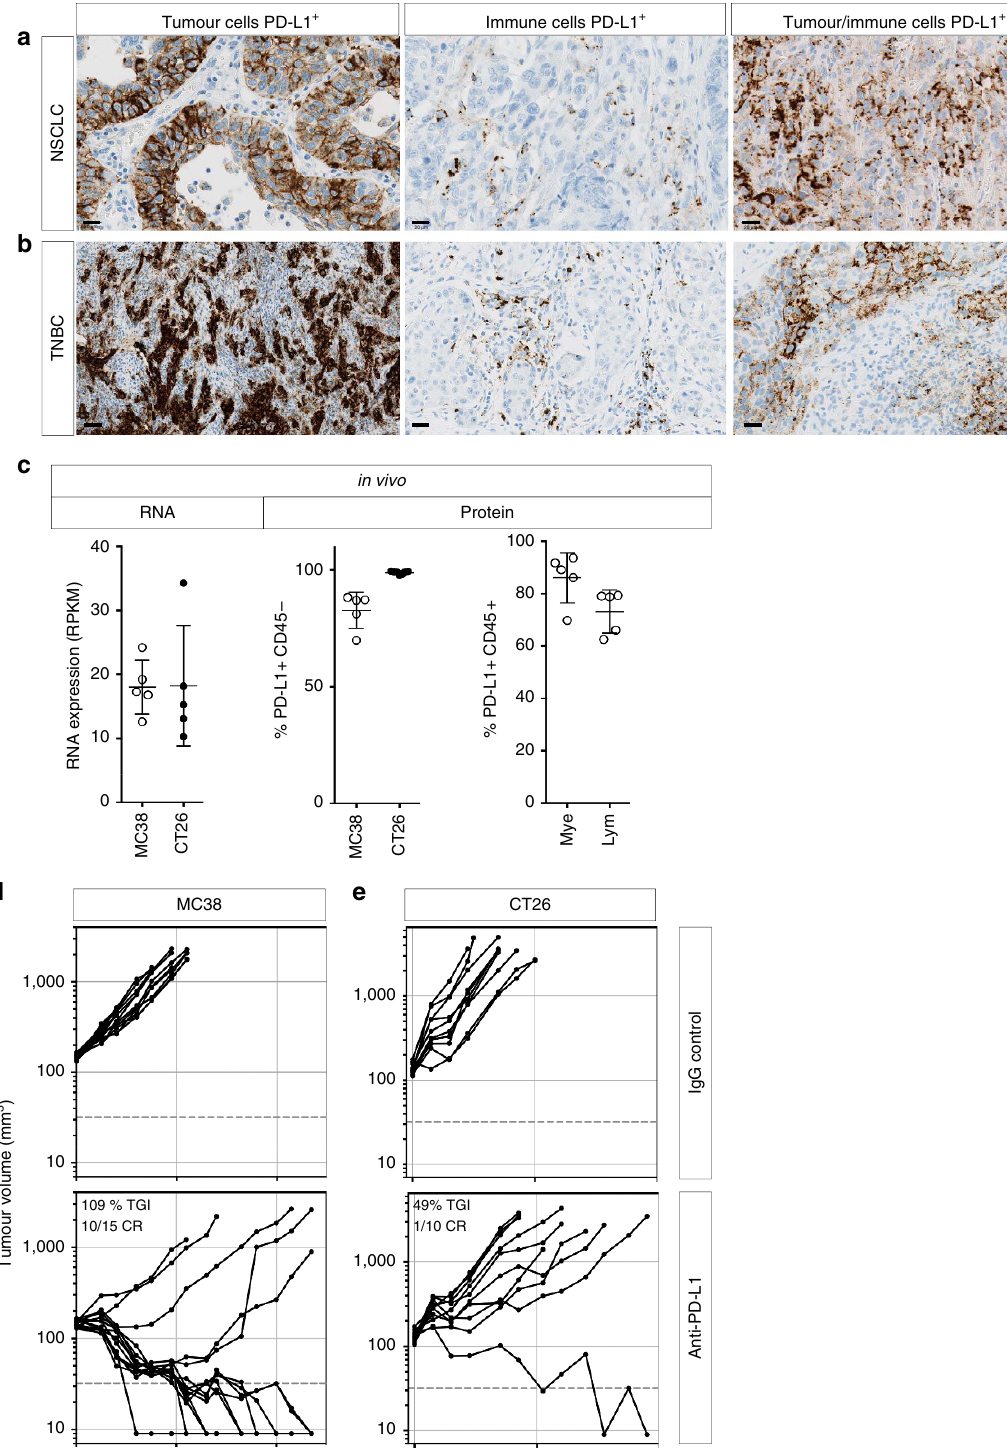
NATURE COMMUNICATIONS|8:14572|DOI: